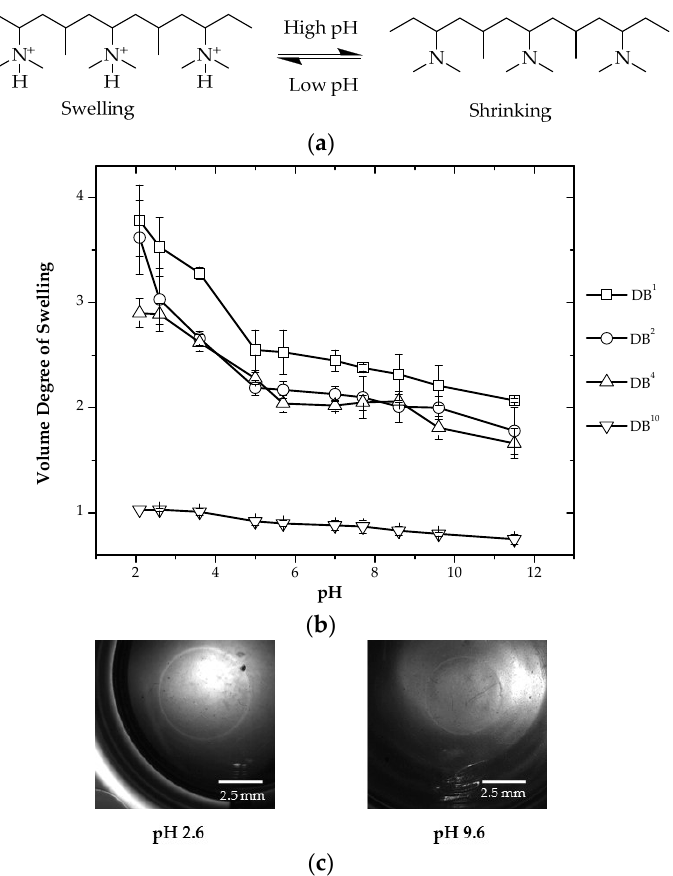
Figure 1. ( a ) Chemical composition of System I hydrogels in different pH states; ( b ) variation of the volume degree of swelling with pH for different compositions of hydrogels; ( c ) optical micrographs showing the change in diameter of DB 4 hydrogels at pH 2.6 and 9.6.